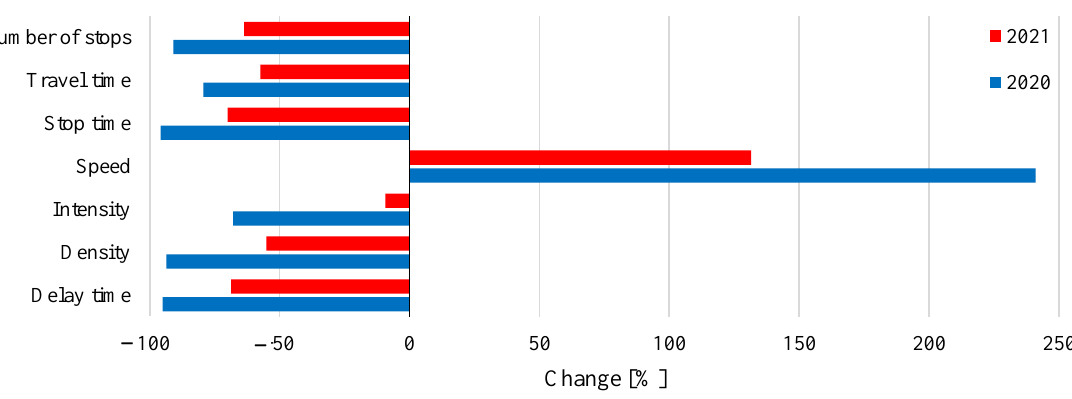
− Figure 4. Percentage changes of monitored parameters compared to 2019. Figure 4. Percentage changes of monitored parameters compared to 2019. The zero axis represents the values of 2019 and reflects the change due to pandemic restrictions. The highest increase was in the speed of vehicles due to the decrease in average traffic intensity. The vehicles passed the intersection smoothly without